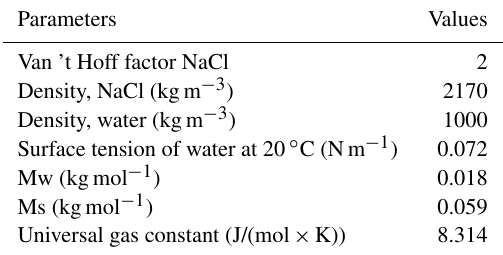
Table 1. Parameters used to calculate the supersaturation for spe- cific critical diameter and temperature (Weast,